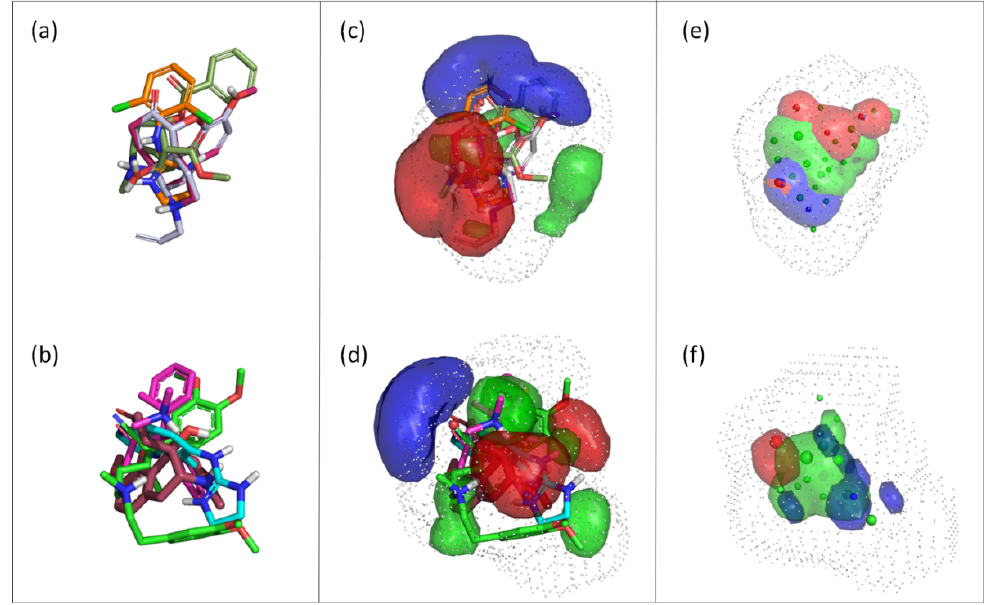
Figure 3. Pharmacophore models for the proton-antiporter substrates generated using FLAP: ( a ) Alignment of the S1 selection and the corresponding pharmacophore model, P1; ( b ) Alignment of the S2 selection and the corresponding pharmacophore model P2. For pharmacophores P1 and P2, oxycodone (dark red) is depicted in the same orientation as the reference.; ( c ) Representation of the FLAPpharm pharmacophore for S1 in the PIFs mode; ( d ) Representation of the FLAPpharm pharmacophore for S2 in the PIFs mode; ( e ) Representation of the FLAPpharm pharmacophore for S1 in the pseudoPIFs mode; ( f ) Representation of the FLAPpharm pharmacophore for S2 in the pseudoPIFs mode.